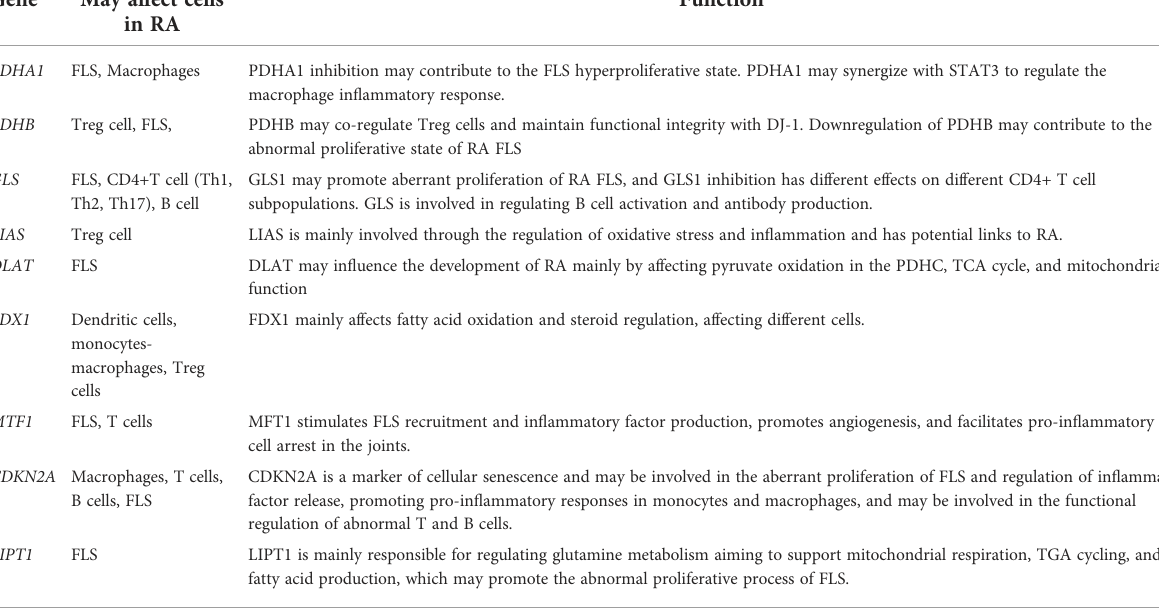
TABLE 1 The potential function of cuproptosis-related genes in